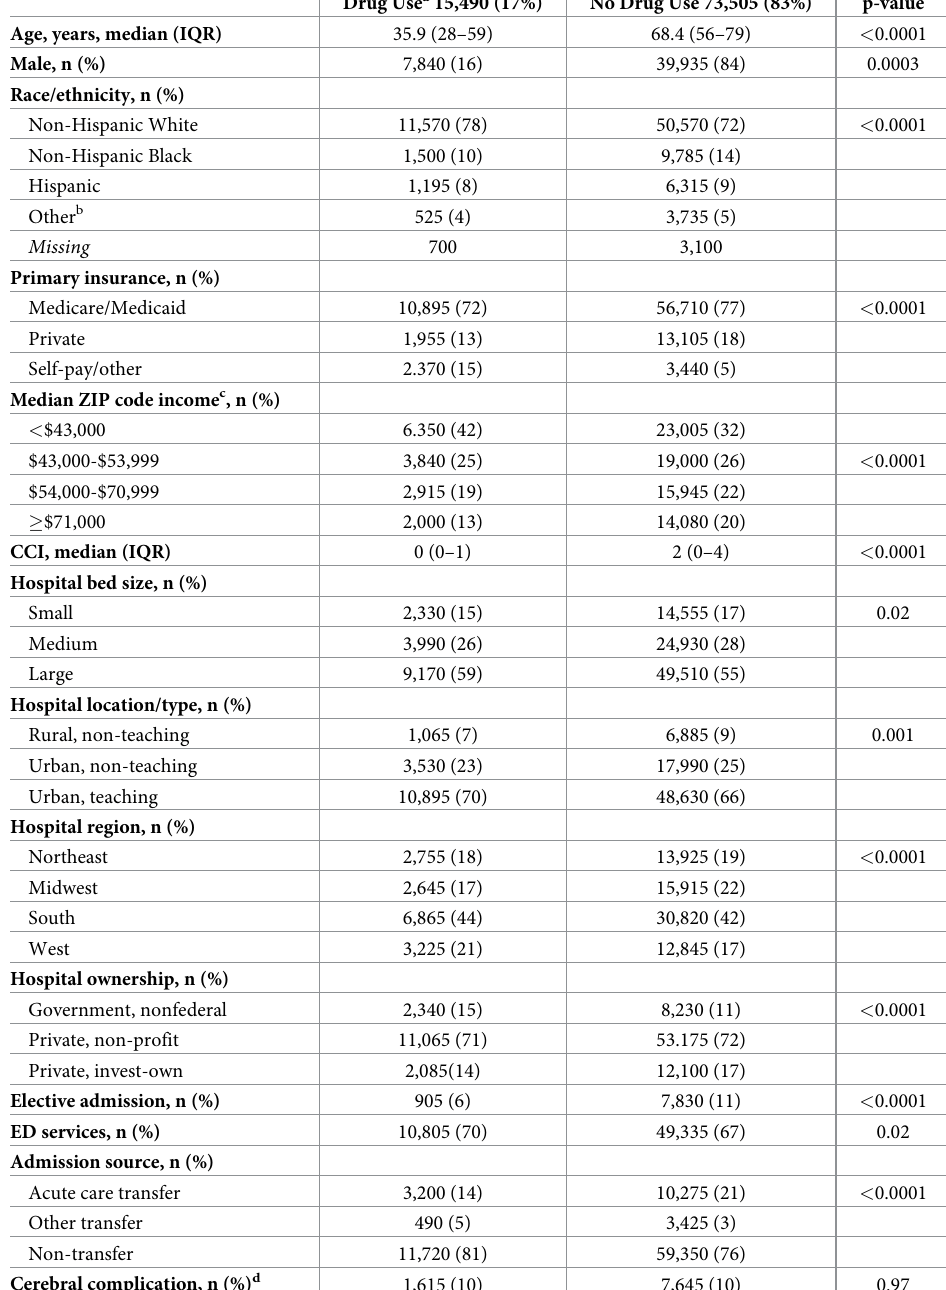
Table 3. Patient demographics and hospital characteristics, stratified by drug